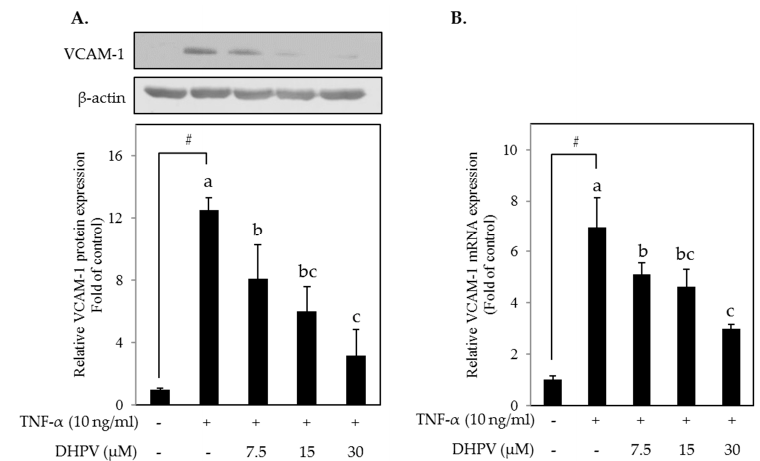
Figure 3. Effect of DHPV on vascular cell adhesion molecule (VCAM-1) expression in TNF- α -stimulated HUVECs. ( A ) Preventive effect of DHPV on TNF- α -stimulated VCAM-1 protein expression as assessed